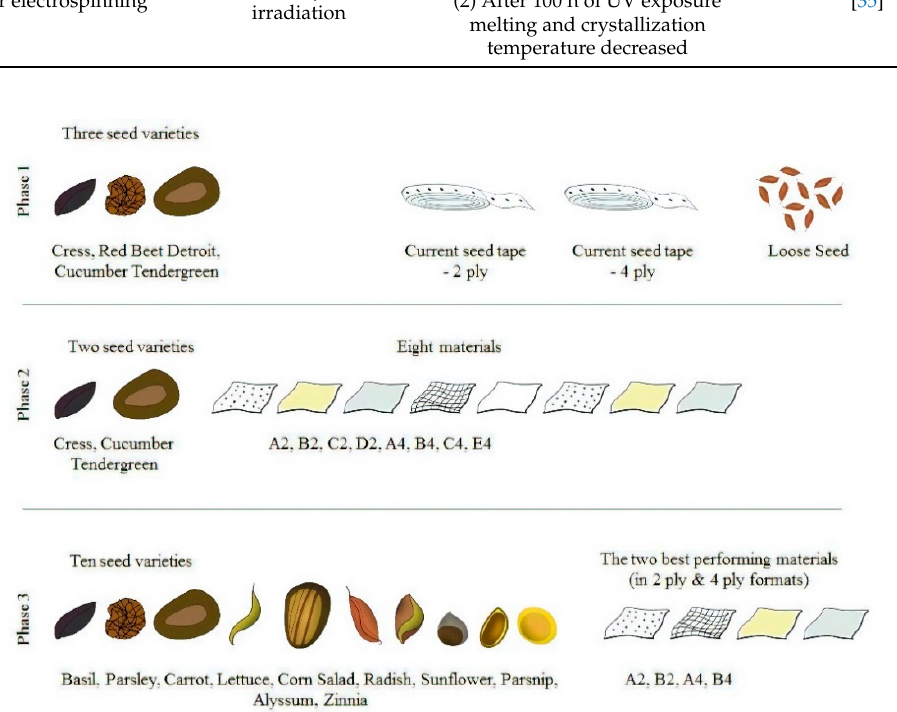
Figure 1. The experimental scheme in Millington’s research [41].